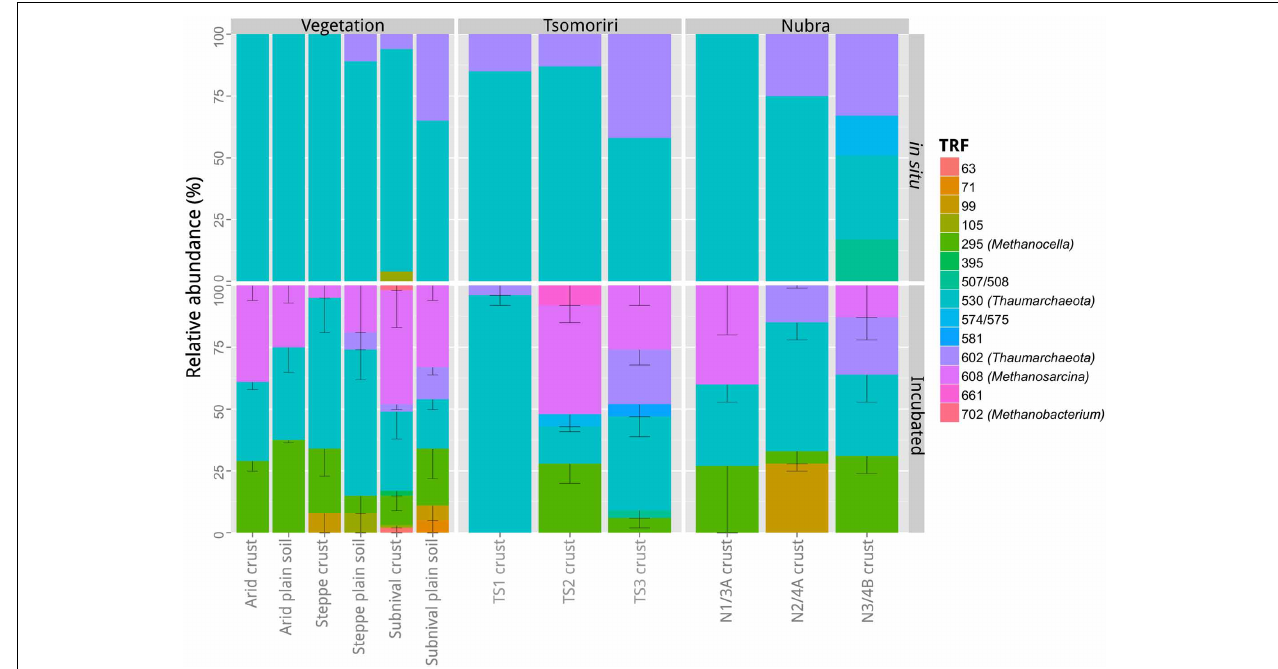
FIGURE 4 | TRFLP community profiles of archaeal 16S rRNA genes from different soil samples. The community composition was characterized in a selection of in situ and incubated soil samples from the three vegetation belts, the lateral moraines in Tsomoriri Plains and the frontal moraines in Nubra Valley. For the incubated